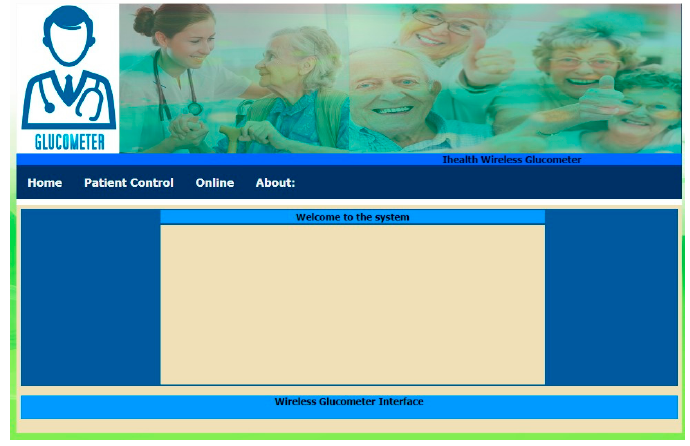
Figure 4. Web page used to visualize profiles.